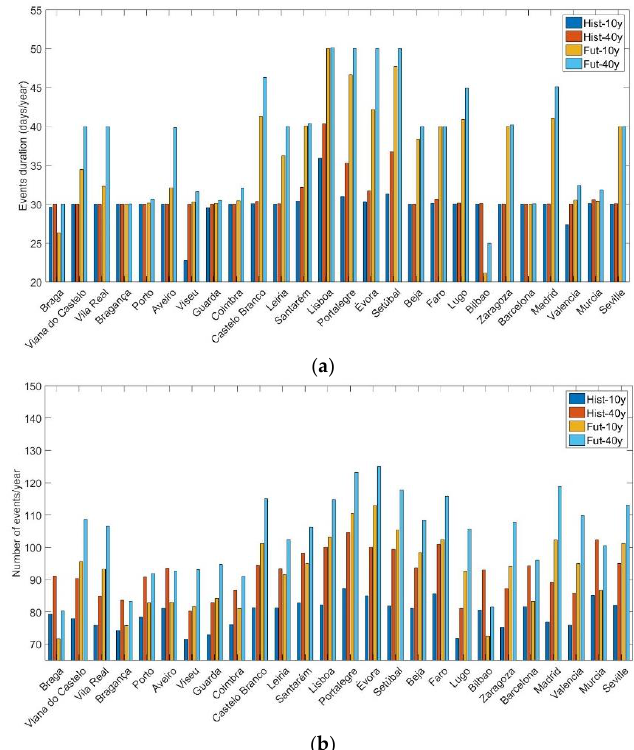
Figure 25. Comparison of the ( a ) event duration (days / year) and ( b ) the number of events (year) in the historical (blue) and future (red) period for extreme events with a return period of 10 years (full line) and 40 years (dashed line) for wind shear (0–3